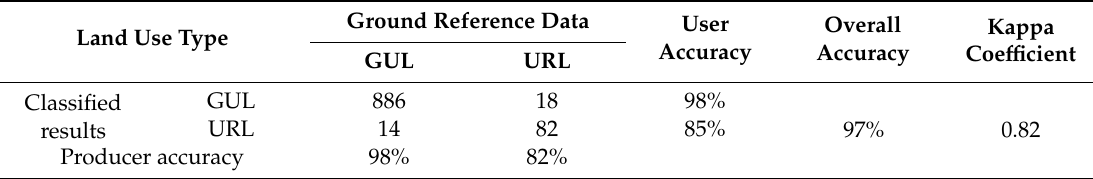
Table 1. Accuracy assessment of urban renewal land and general urban land using the ground reference data from Google Earth.